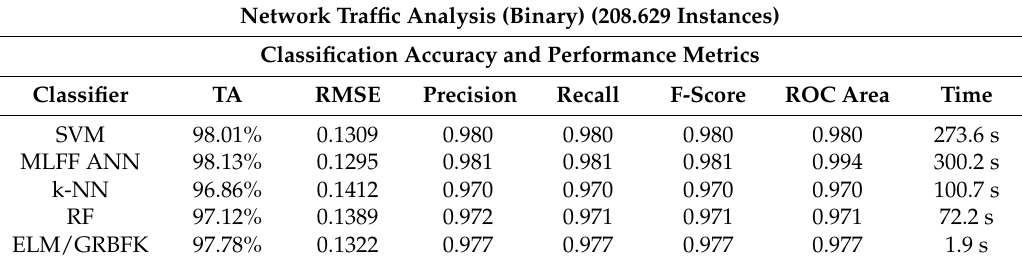
Table 2. Comparison between algorithms.